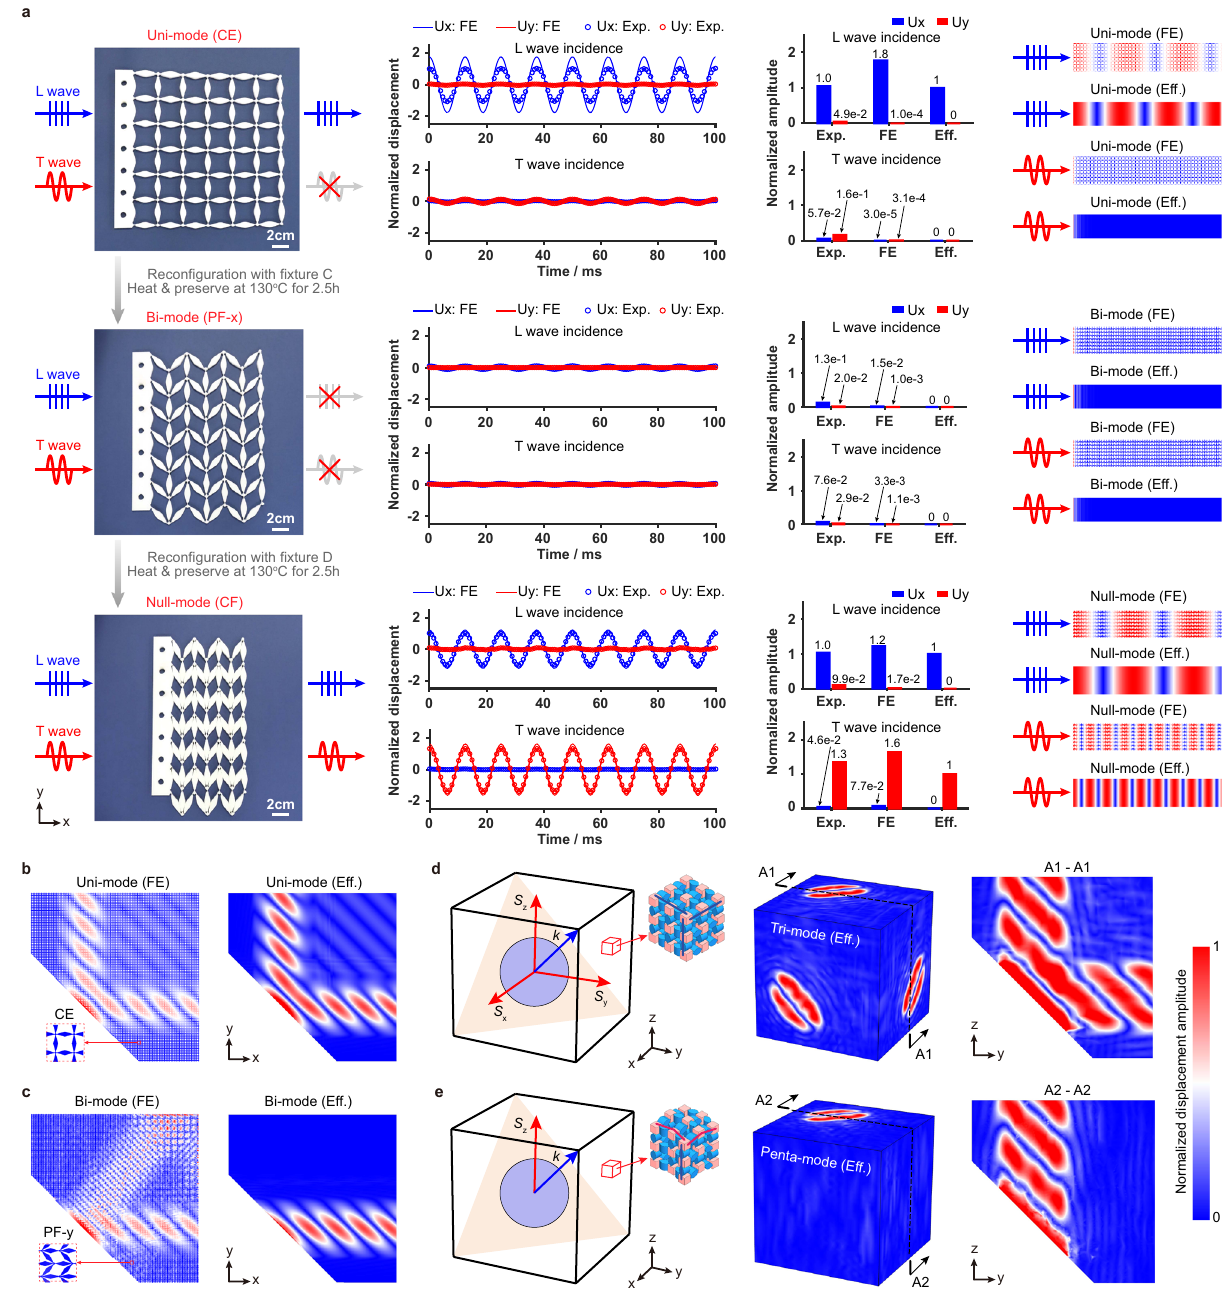
Fig. 4 | Dynamic experiments and wave-function programmability of the transformable metamaterial. a Dynamic experiment of 1D polarized elastic wave manipulation with the fabricated transformable metamaterial sample, validated by thenumericalwavesimulationsonFEsampleandequivalenteffectivemetamaterial